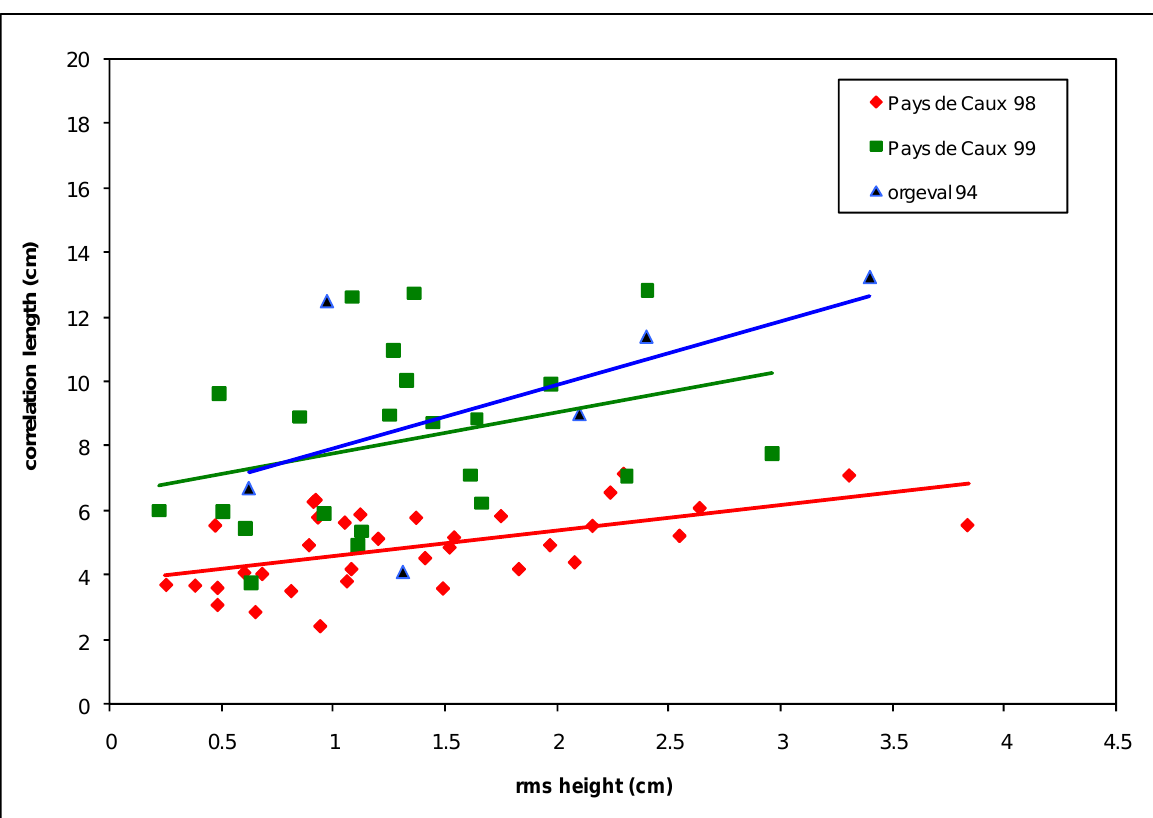
Figure 1. Roughness parameters of the test